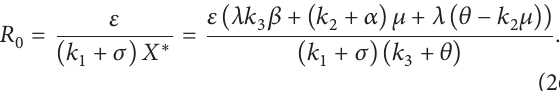
= 0.0002 , 𝜇 = 0.00005 , 𝜎 = 0.0015 , 4 = 28.5484 > 1 . 0